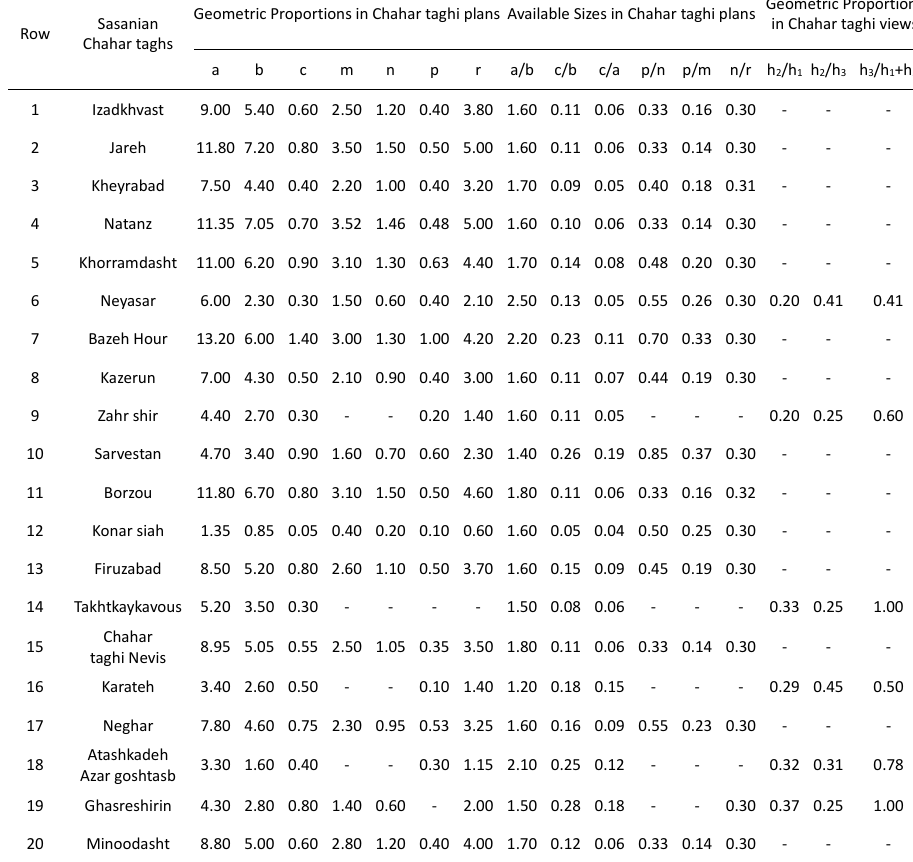
• The ratio of the length of the angular pier to that of Table 3: The results from examination of promotions in square domes Table 3. The results from examination of promotions in square domes